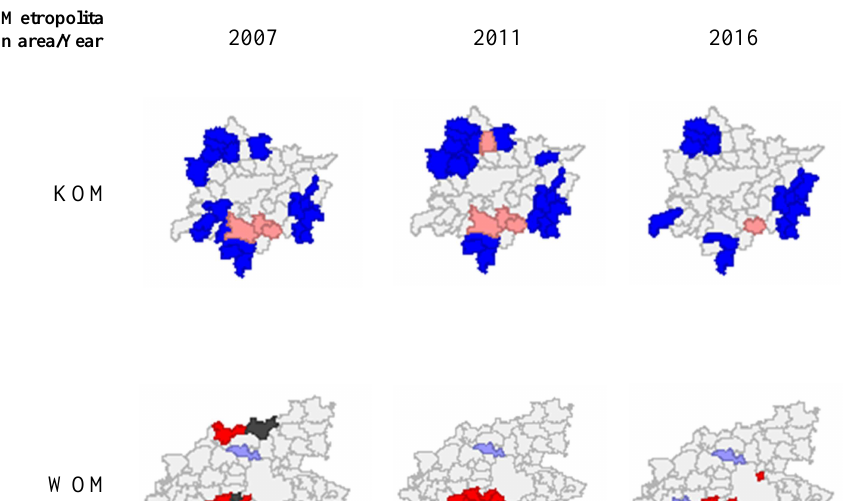
Figure 4. LISA Cluster Map of tax rates on building used for business